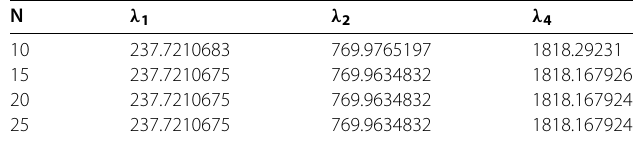
Table 2 The approximate eigenvalues on unit ball B 3 in R 3 N λ 1 λ